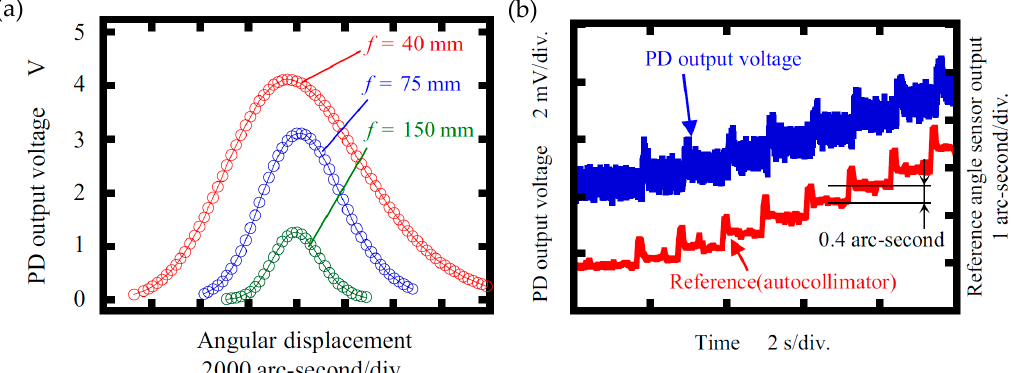
Figure 19. Variation of the light intensity of generated second harmonic light observed in experiments [59]: ( a ) Angle dependency of the second harmonic generation; ( b ) Variation of the light intensity of second harmonic light due to the angular displacement of the BBO crystal in a step of 0.4 arc-seconds.